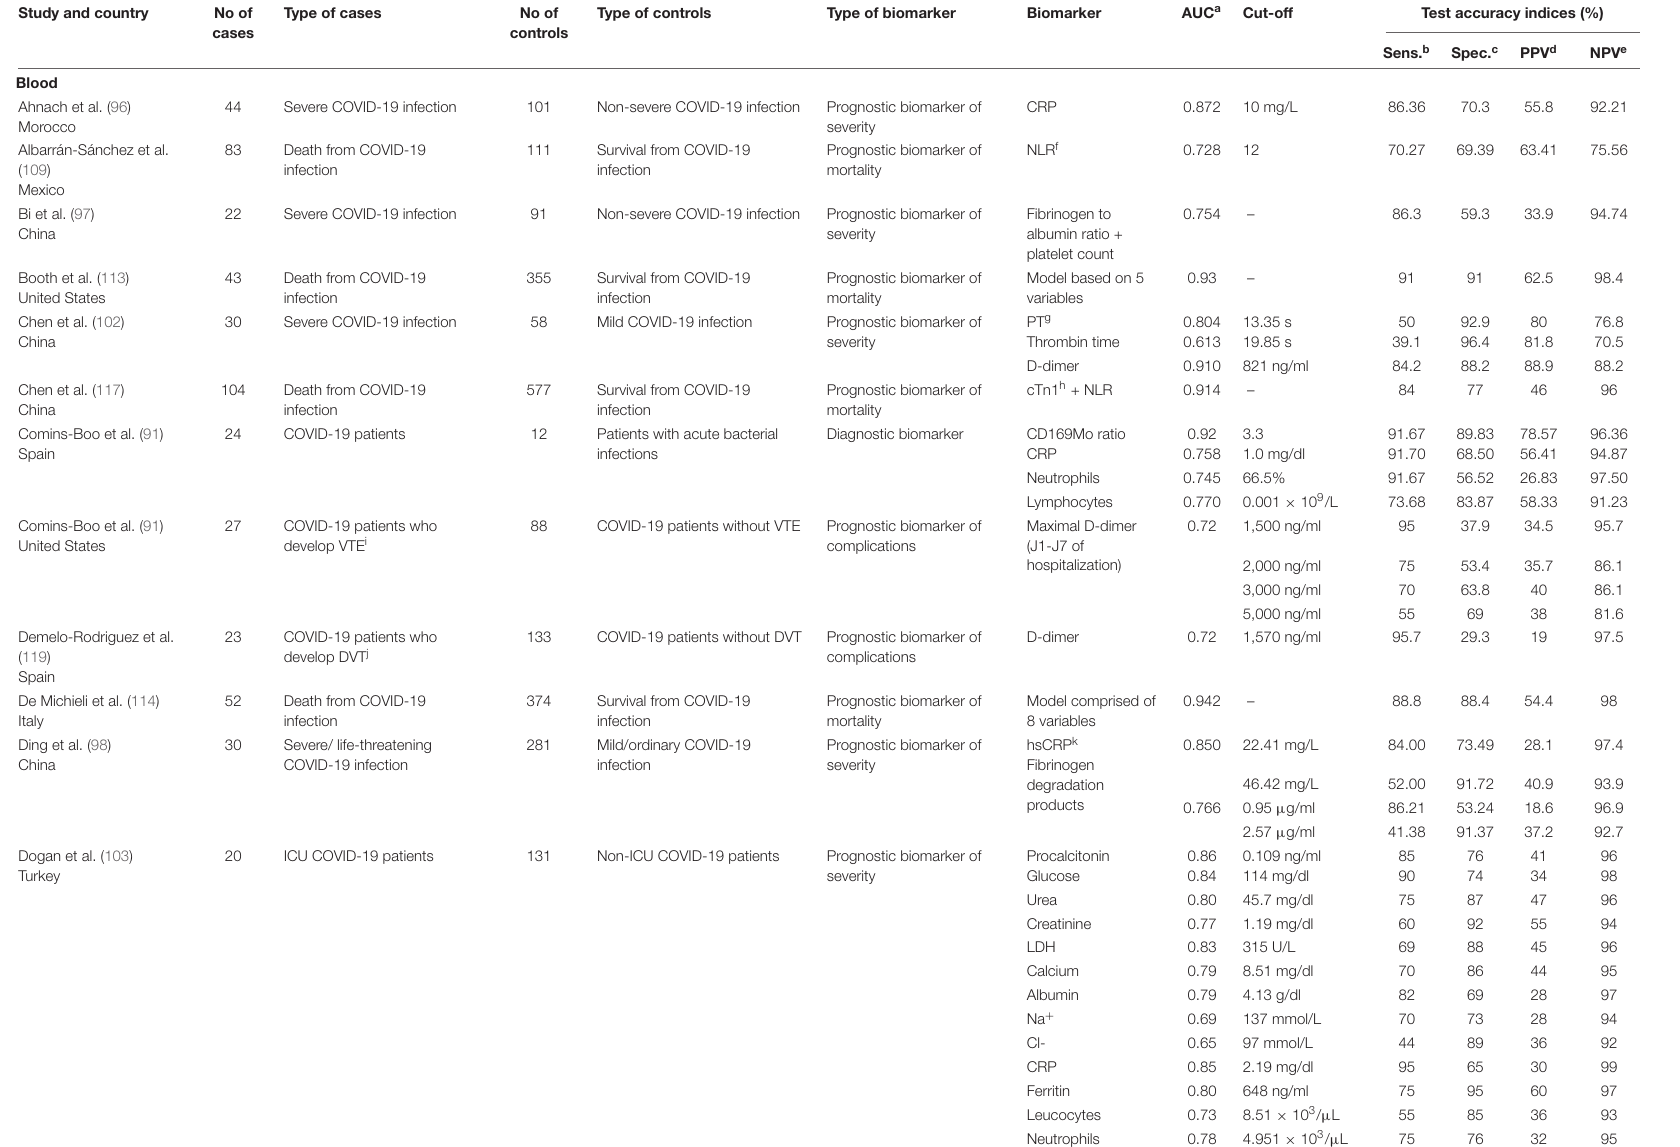
TABLE 4 | Diagnostic accuracies of liquid biomarkers for COVID-19